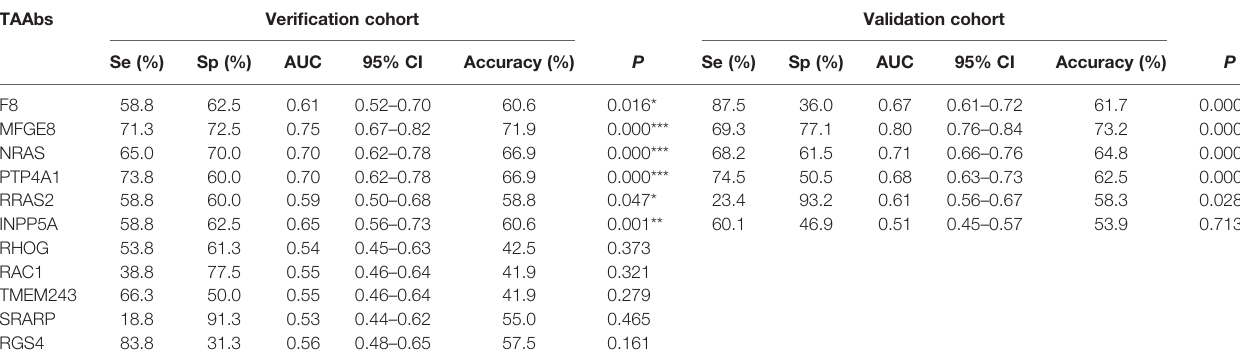
TABLE 2 | Diagnostic value of 11 anti-TAAs autoantibodies in veri fi cation cohort and validation cohort for gastric cancer (GC) detection.